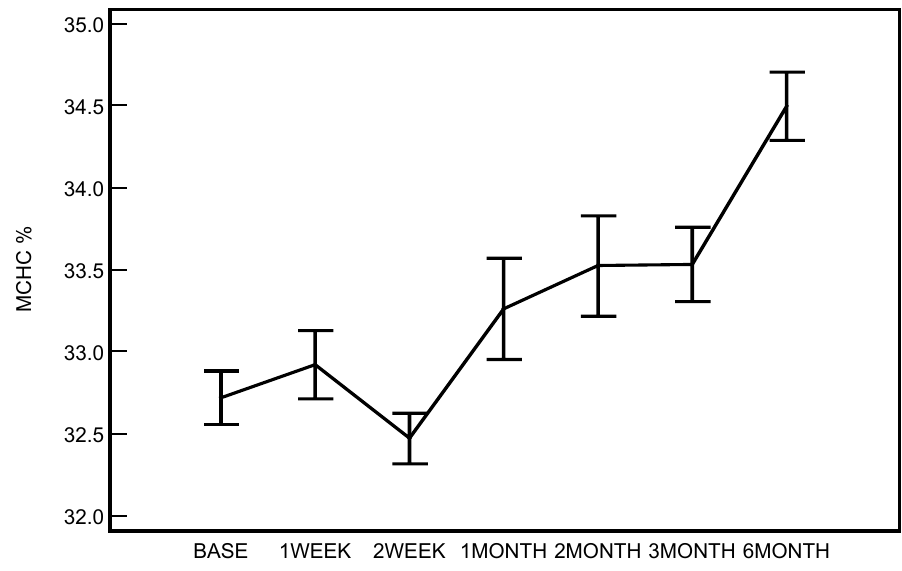
FIGURE 7. Increase in red blood cell MCHC following infusion of the RSC into patients with beta- thalassemia. Artificial values at baseline due to recent transfusion.